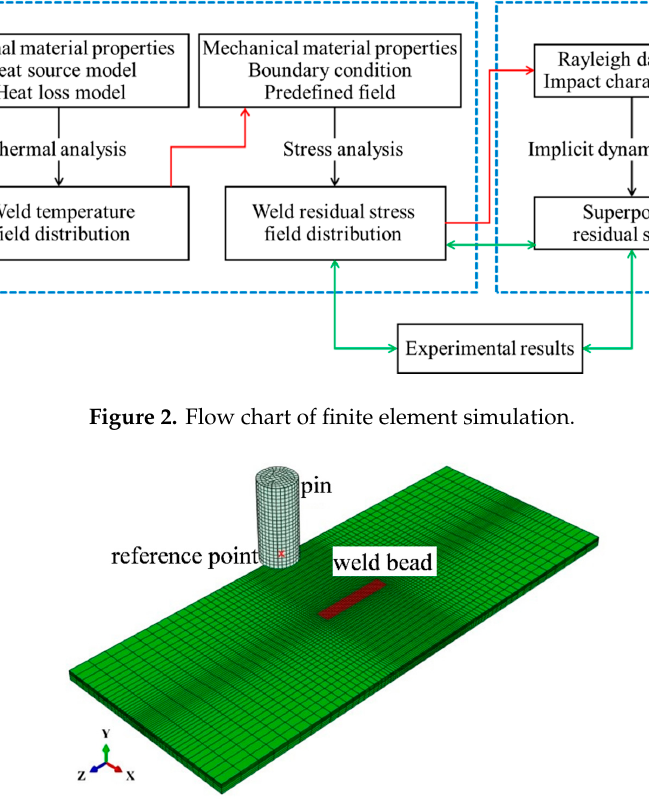
Figure 3. The finite element meshing.